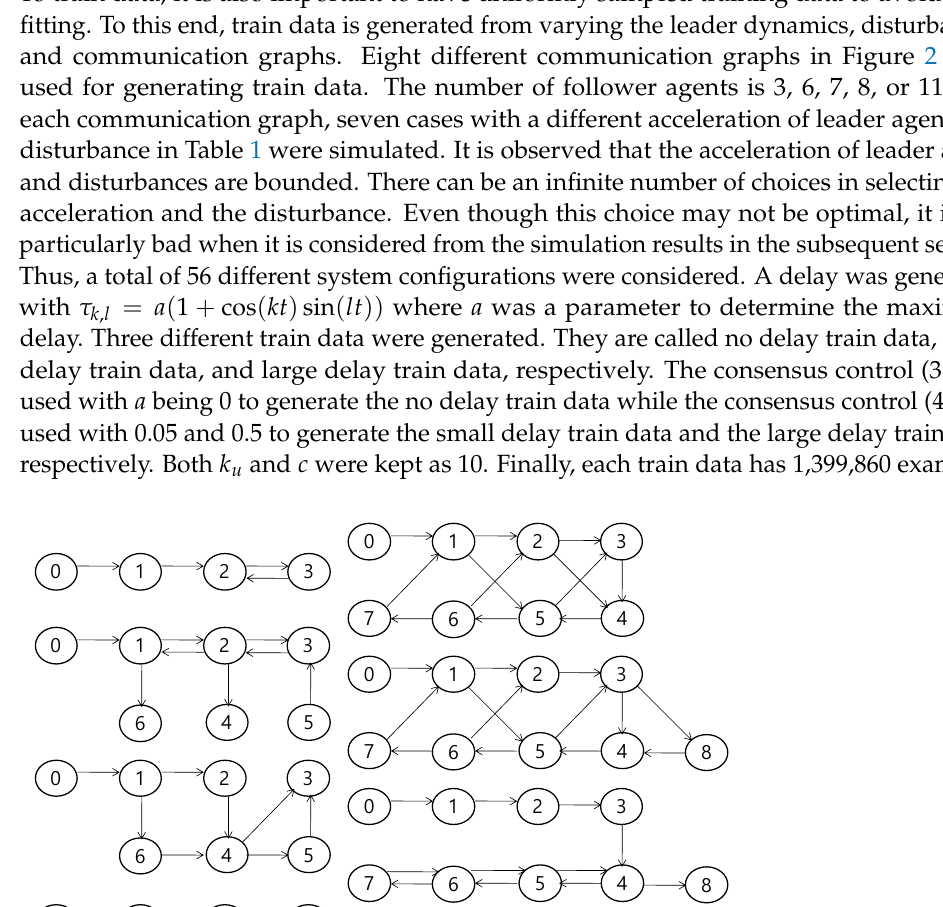
Table 1. Acceleration of leader agent and disturbance used for data generation.